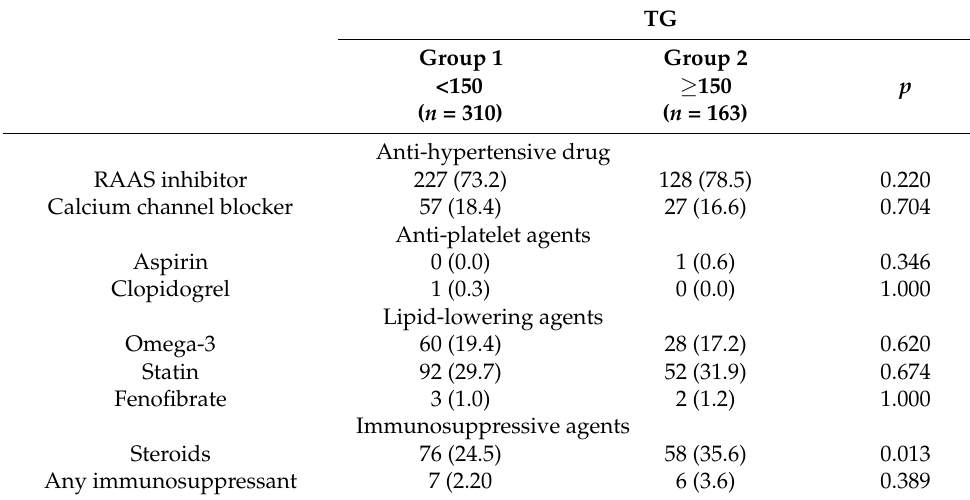
Table 8. Treatment strategies after kidney biopsy in the TG